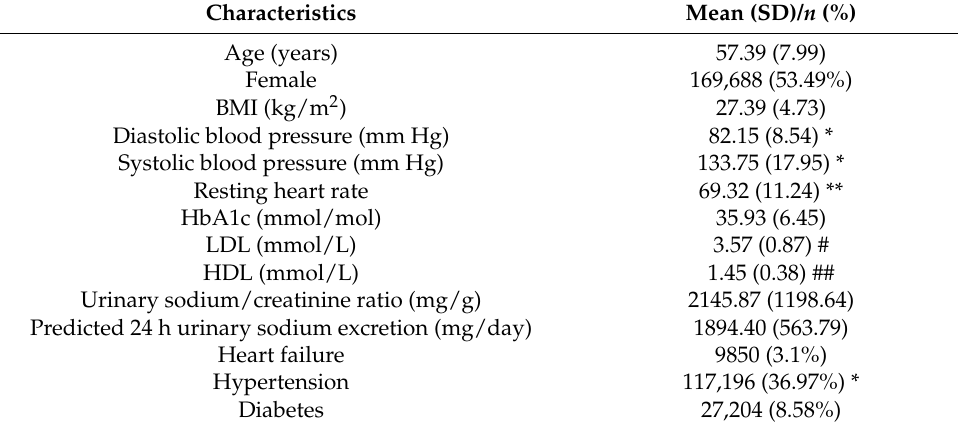
Table 1. Baseline Characteristics of All Included UK Biobank Participants.